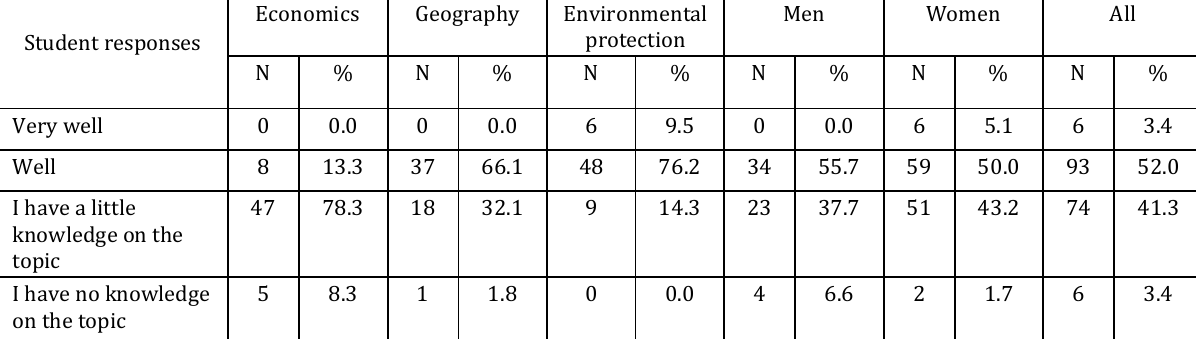
Table 5. The responses of the students to the question 11 - "How do you rate your level of knowledge regarding environmental issues?"